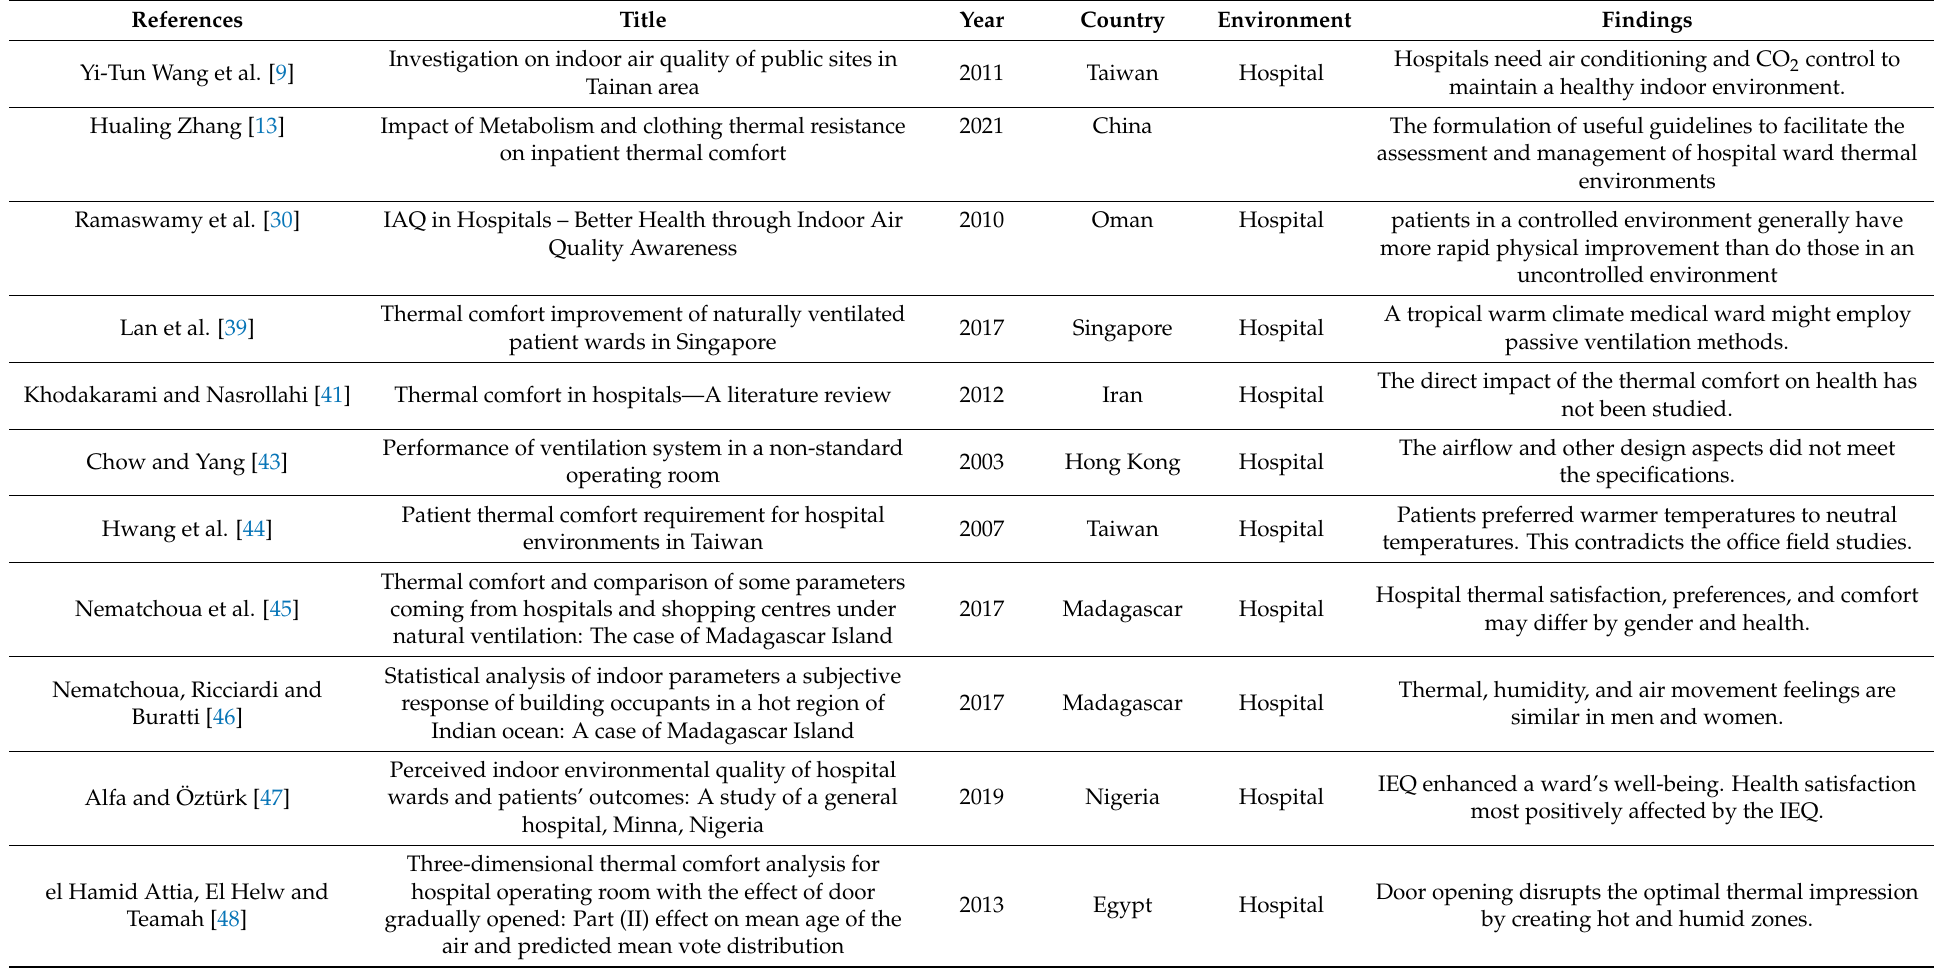
Table 2. Sampled articles in the